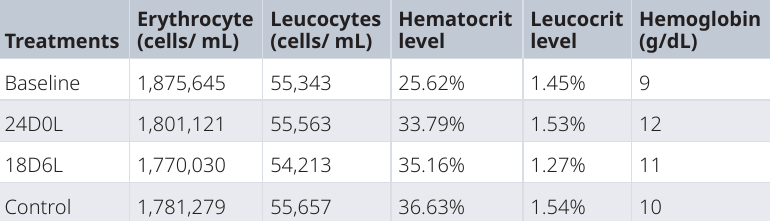
Table 2. Hematological analysis of Pangasionodon hypophthalmus reared under manipulated photoperiod.